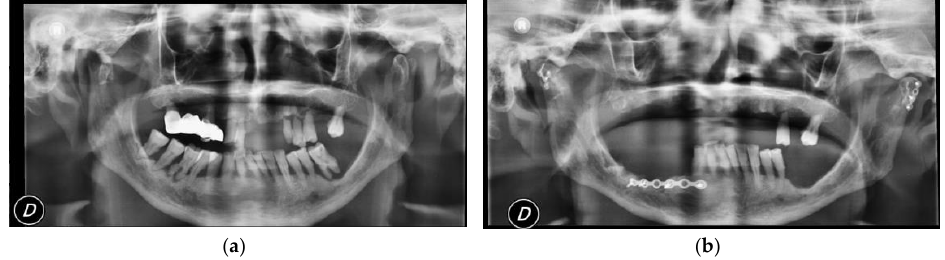
Figure 2. ( a ) Pre- operatory coronal CT scan; ( b ) post-operatory coronal CT scan of patient #2.